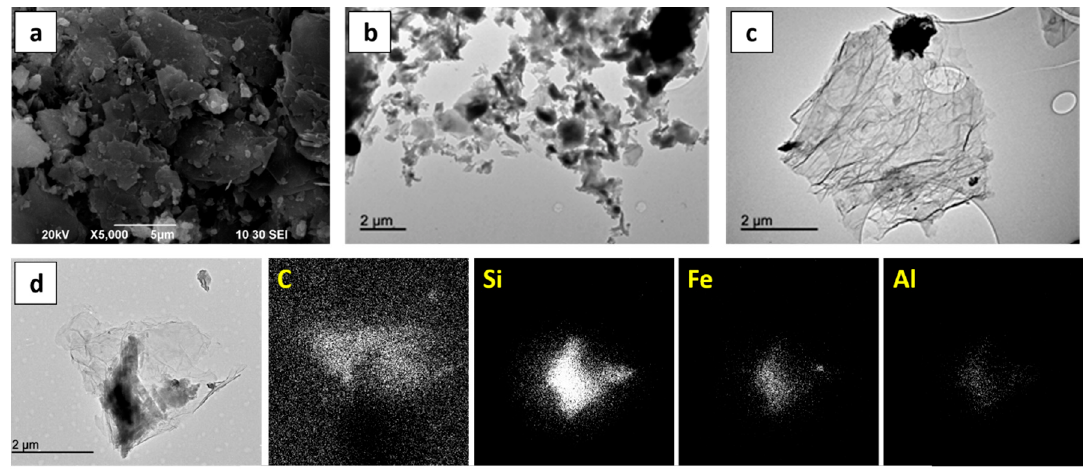
Figure 4. SEM image of NG ( a ); TEM image of GO ( b ); TEM image of GNS ( c ); EDAX mapping of C, Si, Fe and Al for a GNS sample ( d ).